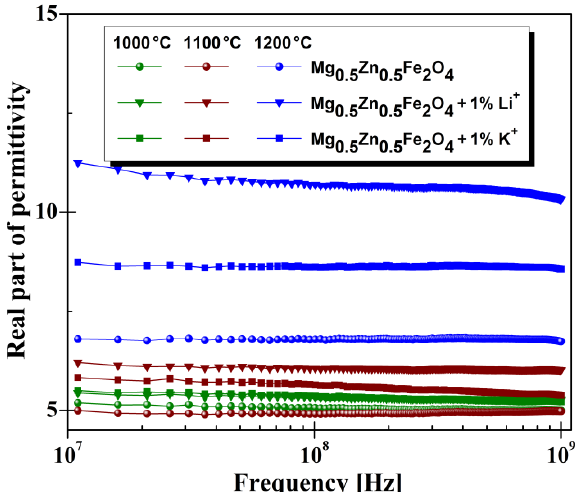
Figure 6. Imaginary part of permittivity vs. frequency for investigated magnesium-zinc ferrites.